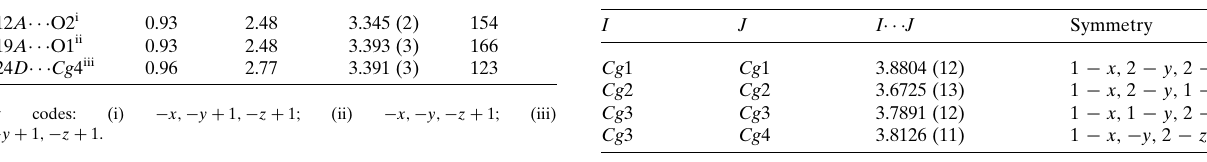
hydrogen bonds (Table 1) connect the molecules into (14) ring motifs. These dimers centrosymmetric dimers with R 2 2 are further linked into infinite sheets stacked along the a -axis